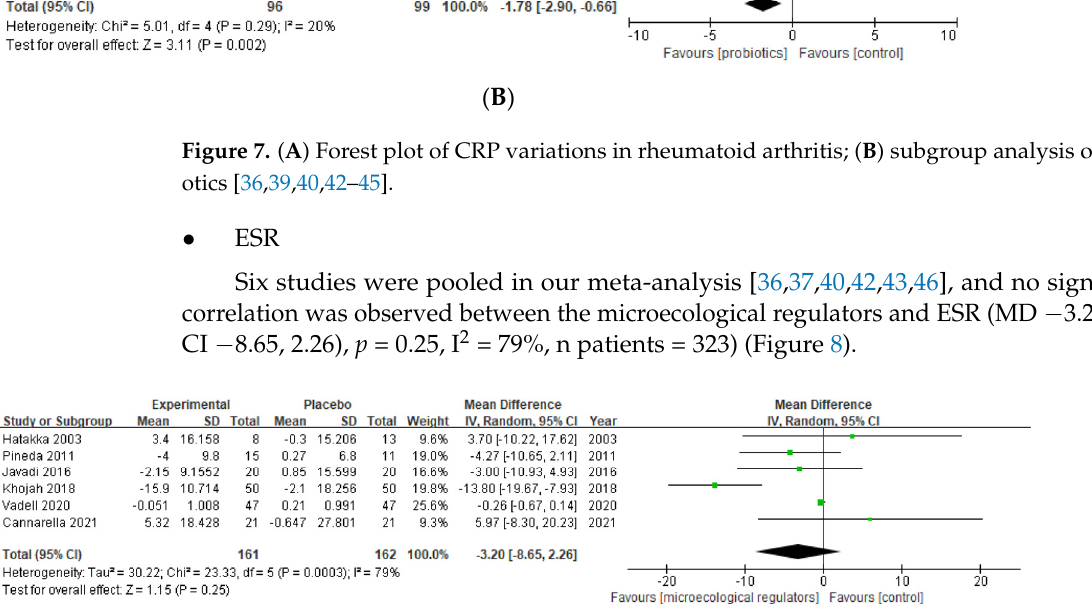
Figure 8. Forest plot of ESR variations in rheumatoid arthritis [36,37,40,42,43,46].